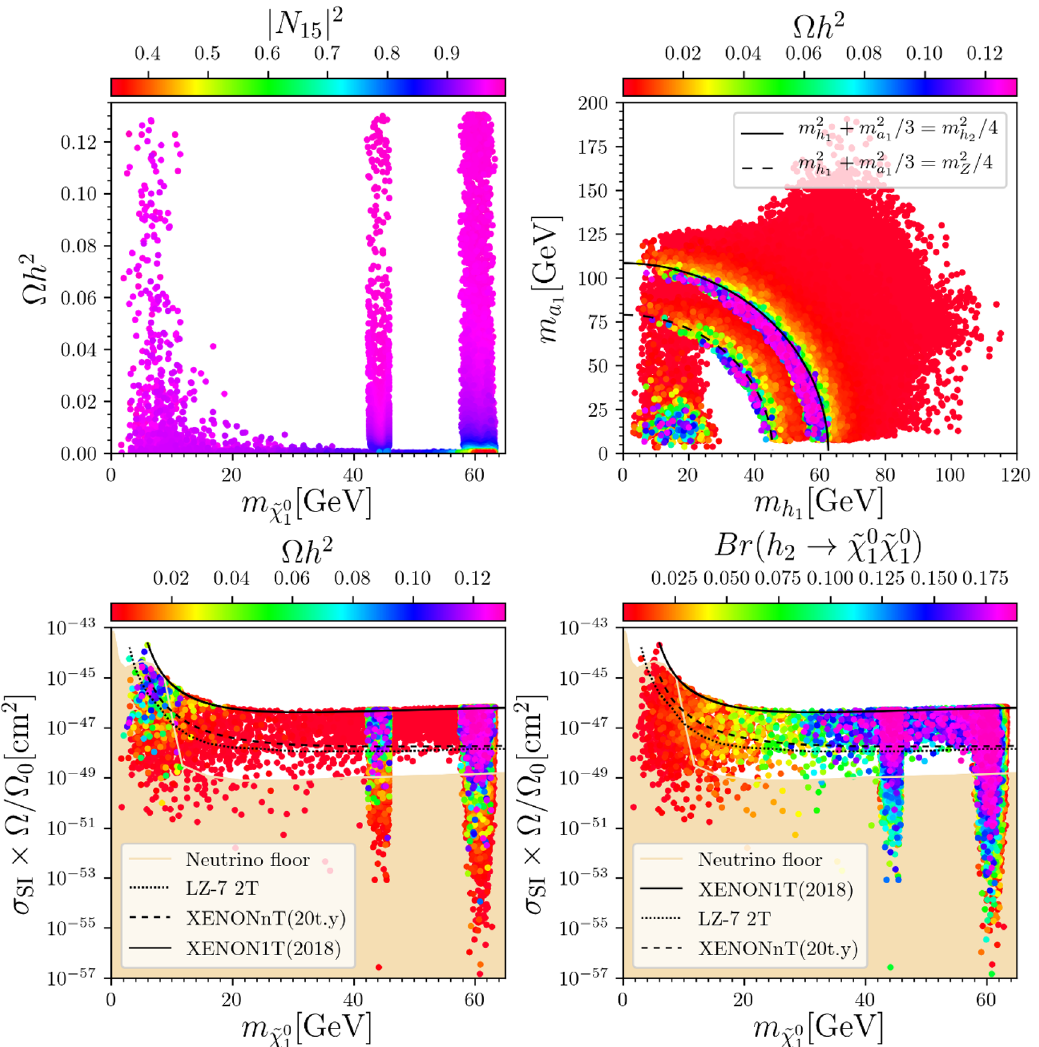
Figure 5 . Upper panel: the surviving samples in the DM relic density (cid:10) h 2 versus the lightest neutralino (LSP) mass m (left), and the CP-odd Higgs mass m a versus the CP-even Higgs ~ (cid:31) 0 1 1 mass m h (right) planes. Colors indicate the singlino component j N 15 j 2 in the ~ (cid:31) 0 (left), and the 1 1 DM relic density (cid:10) h 2 (right) respectively. In the right panel, the black solid and dashed curves indicate m 2 + m 2 = 3 = m 2 = 4 and m 2 + m 2 = 3 = m 2 = 4 respectively. Samples with larger a 1 a 1 Z h 1 h 1 h 2 j N 15 j 2 (left) or (cid:10) h 2 (right) are projected on top of the smaller ones. Lower panel: the surviving samples in the spin-independent DM-nucleon scattering cross section ( (cid:27) SI (cid:2) (cid:10) = (cid:10) 0 ) versus the LSP mass m planes. Colors indicate the DM relic density (cid:10) h 2 (left), and the Higgs invisible decay ~ (cid:31) 0 1 Br ( h 2 ! ~ (cid:31) 0 ~ (cid:31) 0 ) (right) respectively. In these two panels, the black solid, dashed and dotted curves 1 1 indicate the limits of spin-independent DM-nucleon cross section (cid:27) SI by XENON1T 2018 [66], the future detection sensitivity of XENONnT and LUX-ZEPLIN (LZ-7 2T), and the orange shaded region indicate the neutrino (cid:13)oor [88]. Samples with larger (cid:10) h 2 (left) or Br ( h 2 ! ~ (cid:31) 0 ~ (cid:31) 0 ) (right) 1 1 are projected on top of the smaller ones.